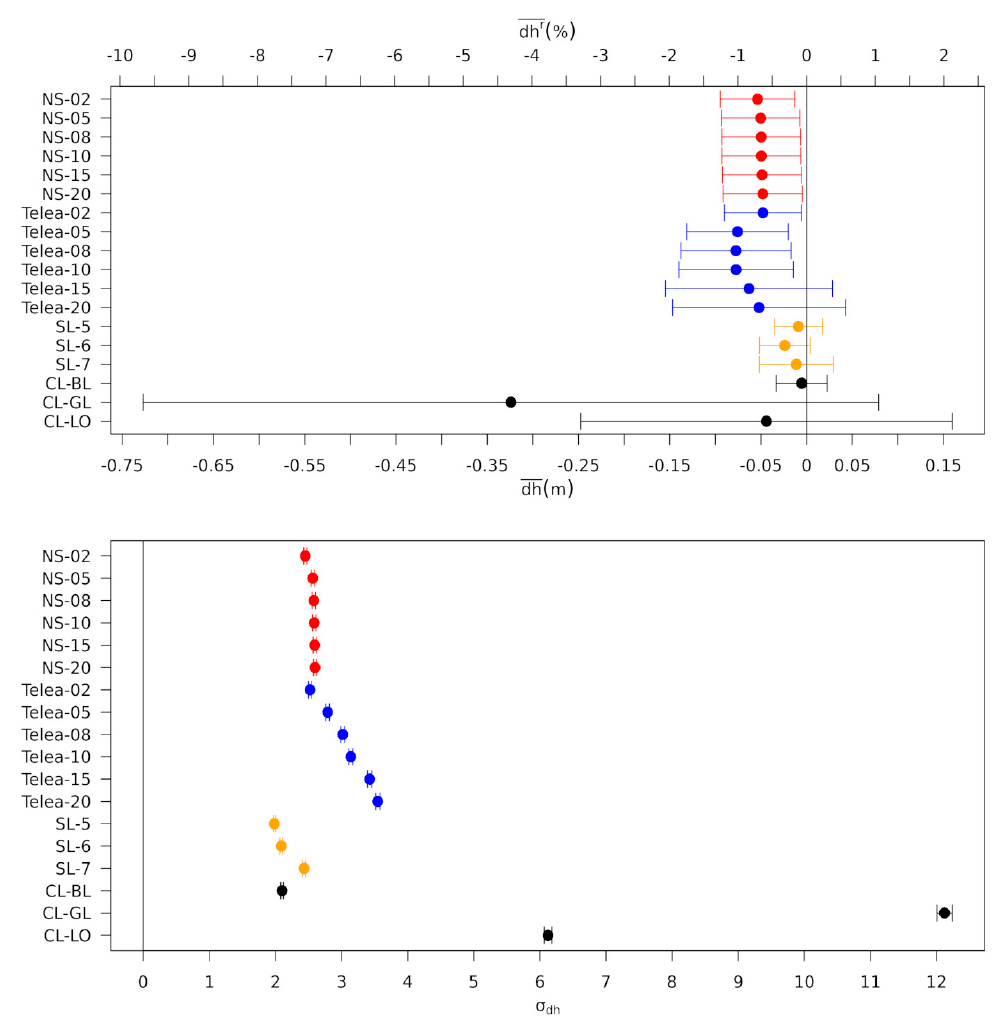
r Figure 6. Mean dh ( dh : relative o ff set to original data) and standard deviation σ dh of sampled o ff set Figure 6. Mean (cid:1856)ℎ(cid:3364)(cid:3364)(cid:3364)(cid:3364) ( (cid:1856)ℎ(cid:3364)(cid:3364)(cid:3364)(cid:3364) (cid:3045) : relative offset to original data) and standard deviation (cid:2026) (cid:3031)(cid:3035) of sampled offset values for the Correlation setup including simultaneous confidence values for the Correlation setup including simultaneous confidence intervals.